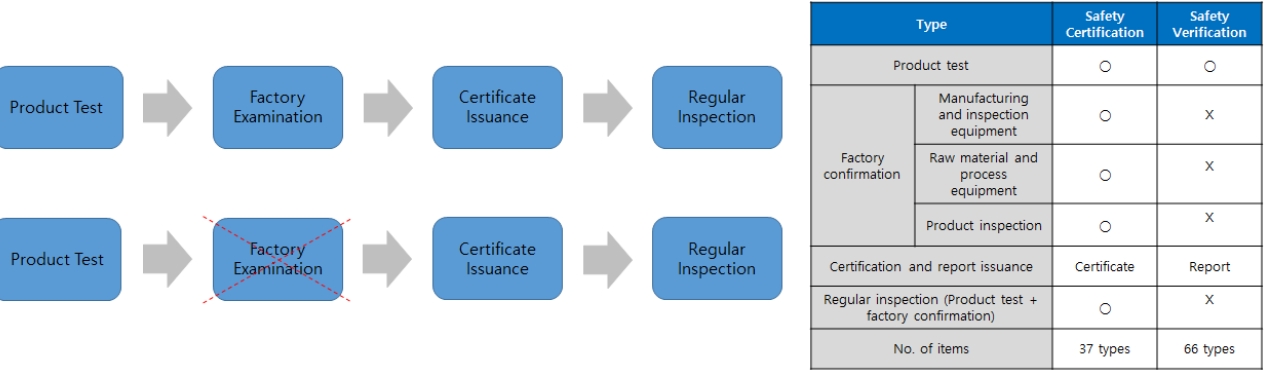
Figure 4. Comparison of procedures for electrical appliances subject to safety certification and those subject to safety verification.